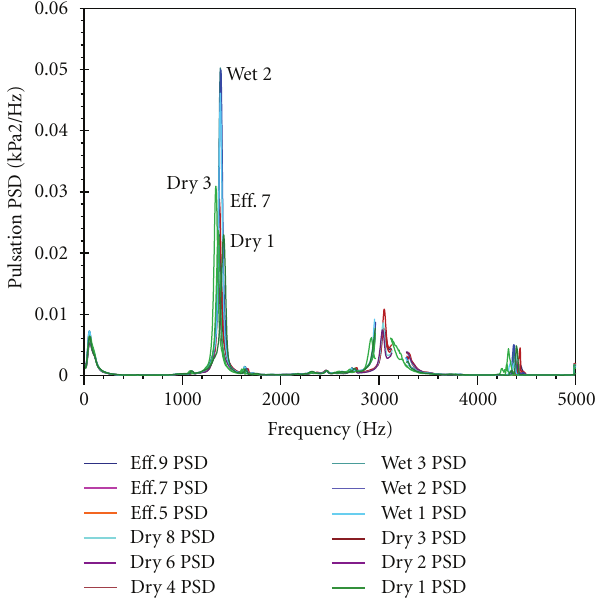
Figure 14: Composite of all pulsation PSD spectra for the 55000 RPM condition.